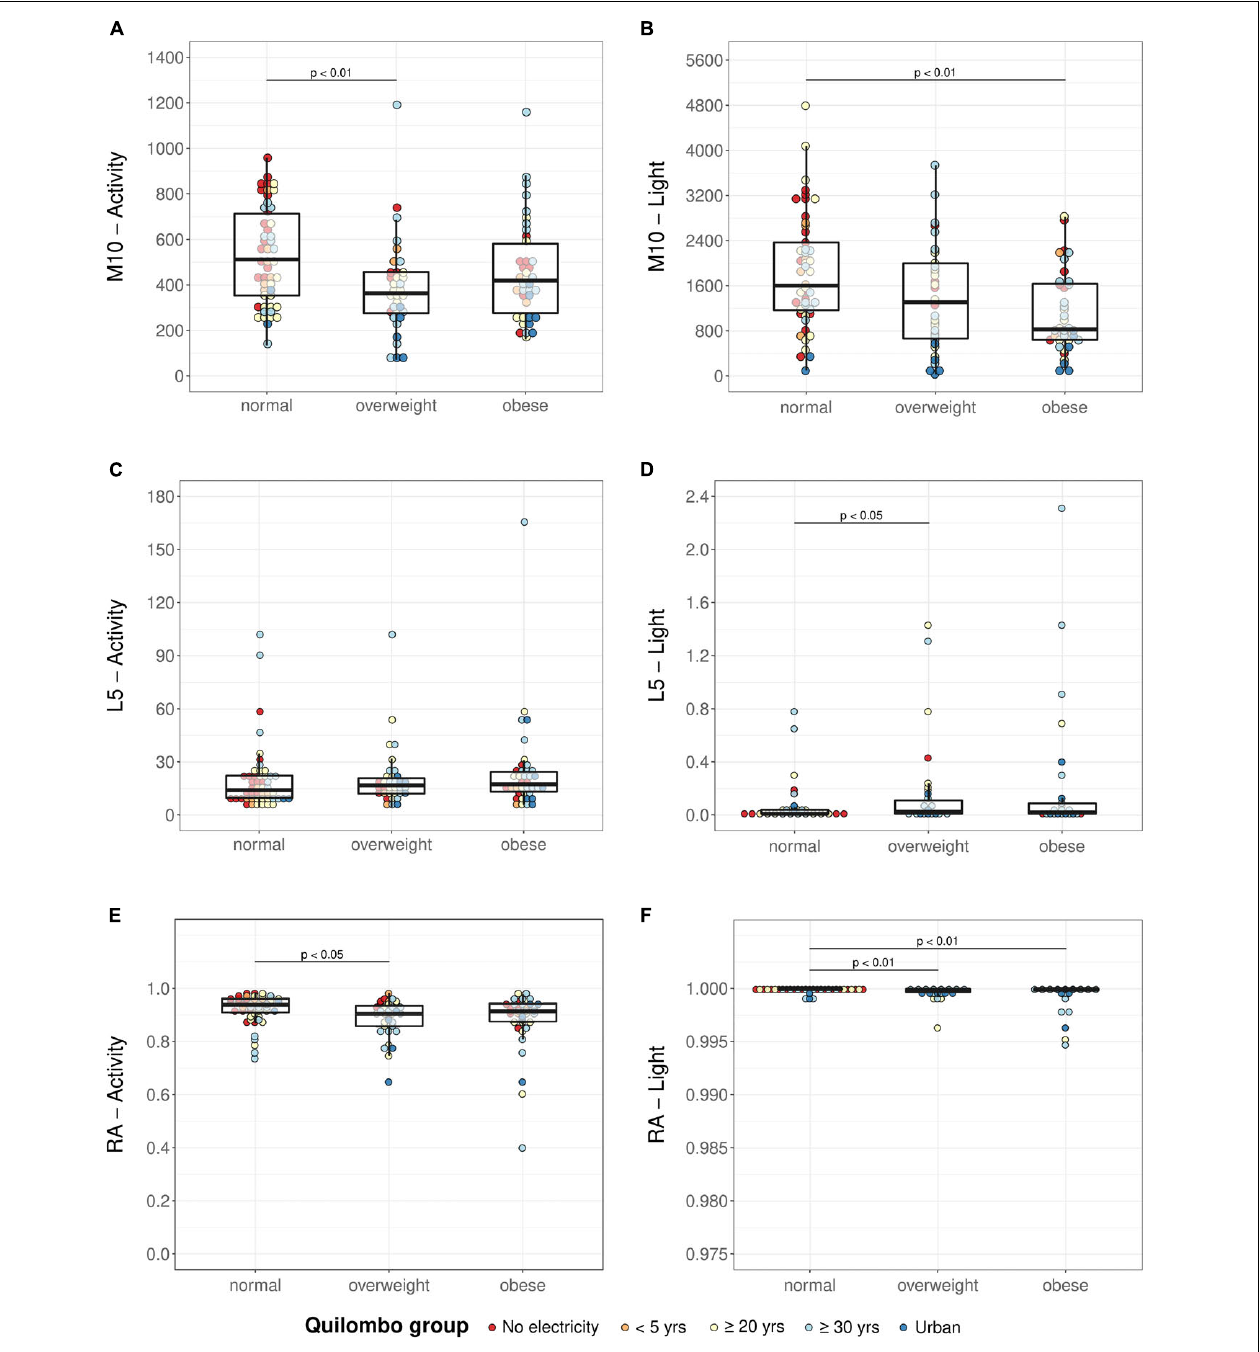
FIGURE 4 | Activity M10 (A) , activity L5 (C) , activity RA (E) , light M10 (B) , light L5 (D) , and light RA (F) in normal-weight, overweight, and obese groups. Analyses were performed using the Kruskal–Wallis test followed by Dunn’s test. M10: mean activity or light exposure of the 10 consecutive hours with the highest values of a daily profile; L5: average activity or light exposure of the 5 consecutive hours with the lowest values of a daily profile; RA, relative amplitude; p -values according to Dunn’s test for multiple comparisons, adjusted with Sidak